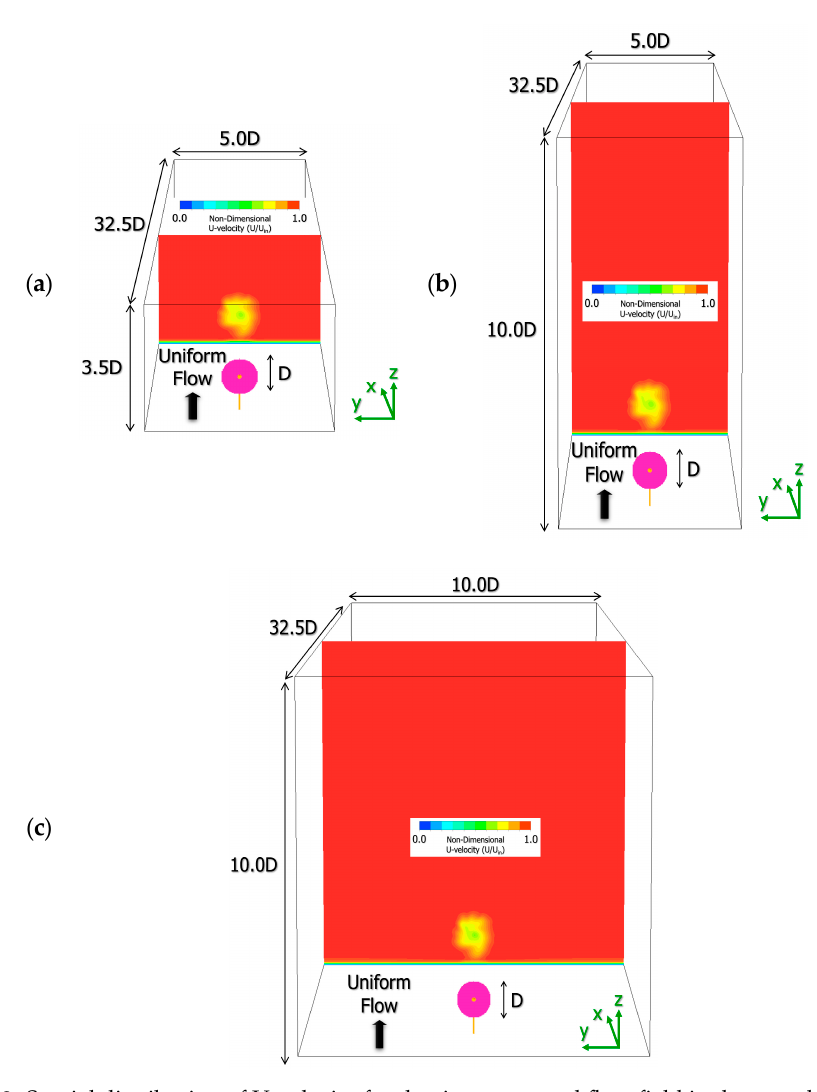
Figure A2. Spatial distribution of U-velocity for the time-averaged flow field in the y–z plane (front view) at x = 5.0 D: ( a ) 32.5 D (x) × 5.0 D (y) × 3.5 D (z), ( b ) 32.5 D (x) × 5.0 D (y) × 10.0 D (z), and ( c )